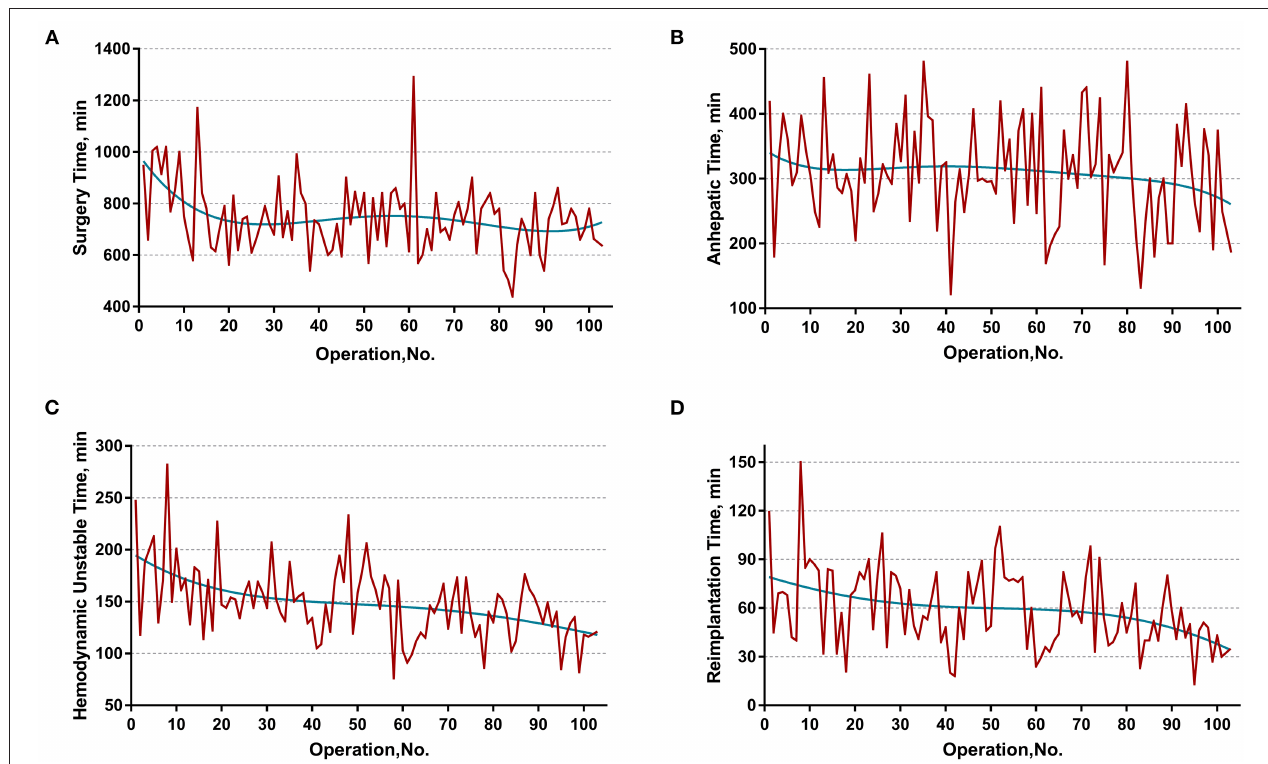
FIGURE 3 | Evolution of overall and staged surgery time in minutes plotted against cases of ELRAs performed. (A) Overall surgery time, (B) anhepatic time, (C) hemodynamic unstable time, (D) reimplantation time. The blue curve represents the curve of best fit for the plots. Mild moderating trends were observed in all fitted